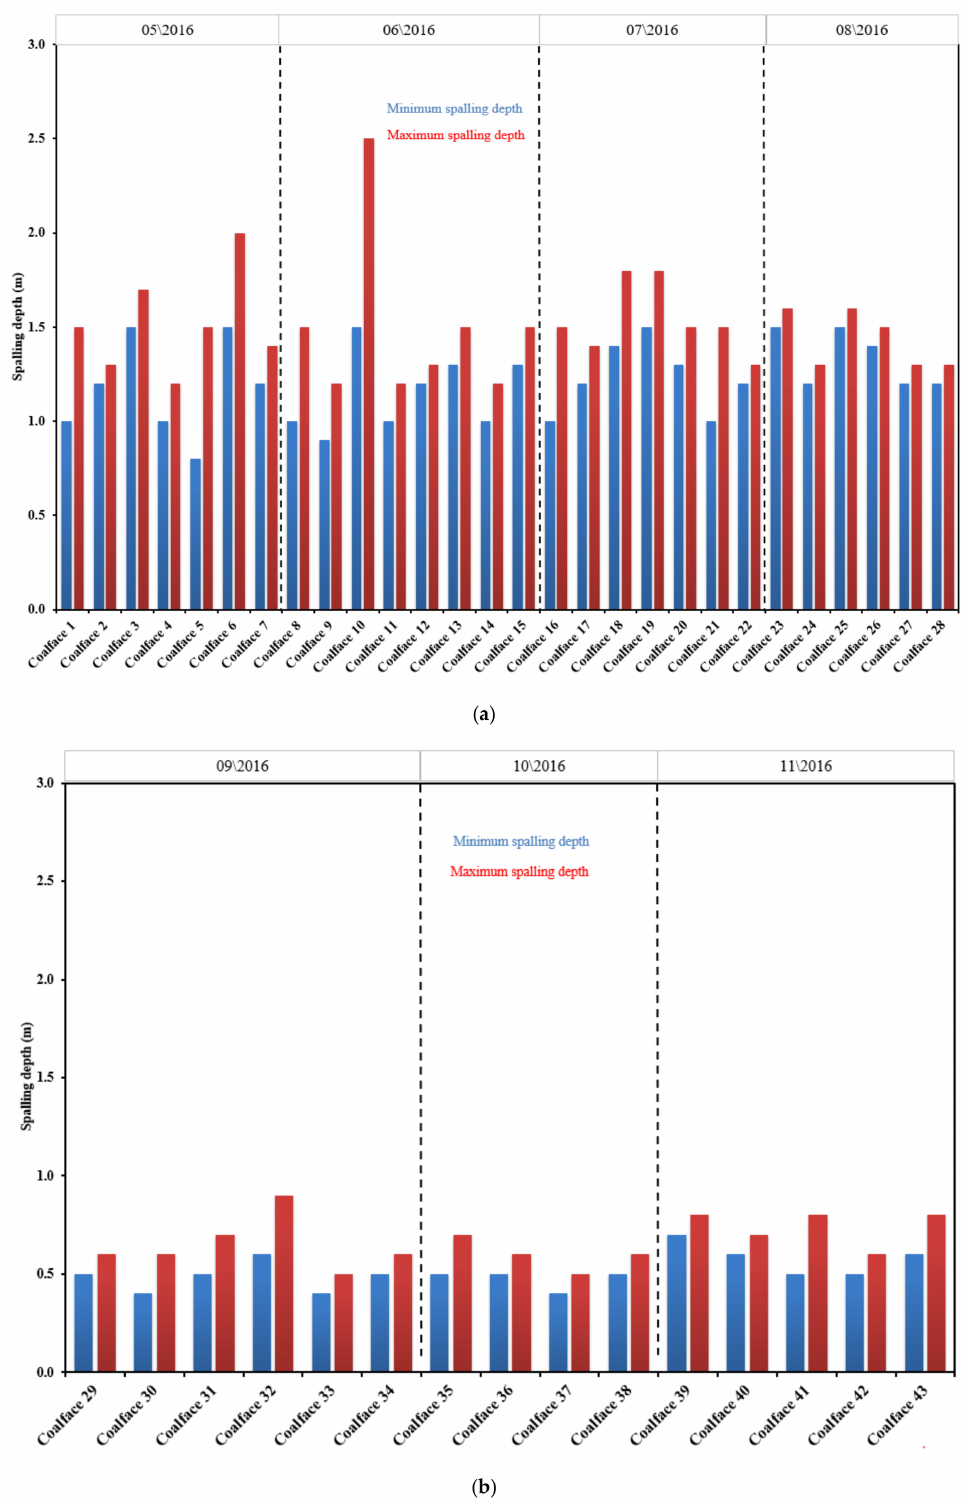
Figure 10. Monitored spalling depths of various coalfaces of the coal seam without ( a ) and with ( b ) the water infusion